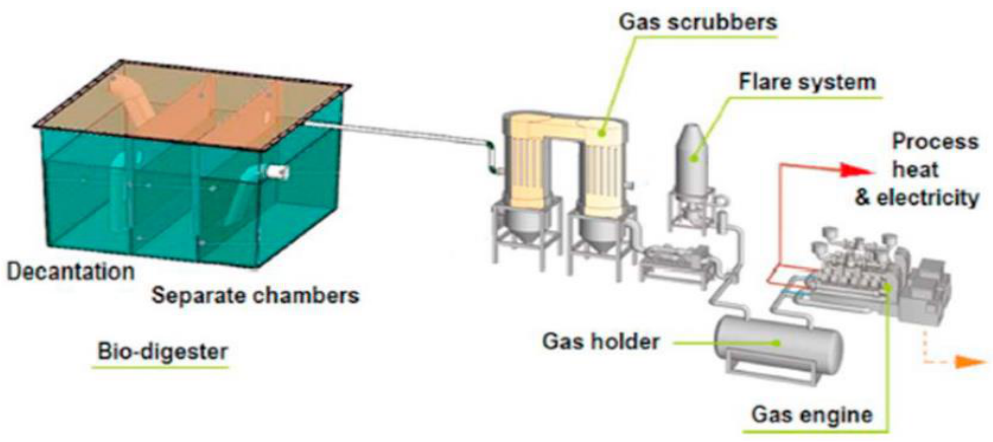
Figure 2: Combined heat and power bio-refinery to treat MSW [15].